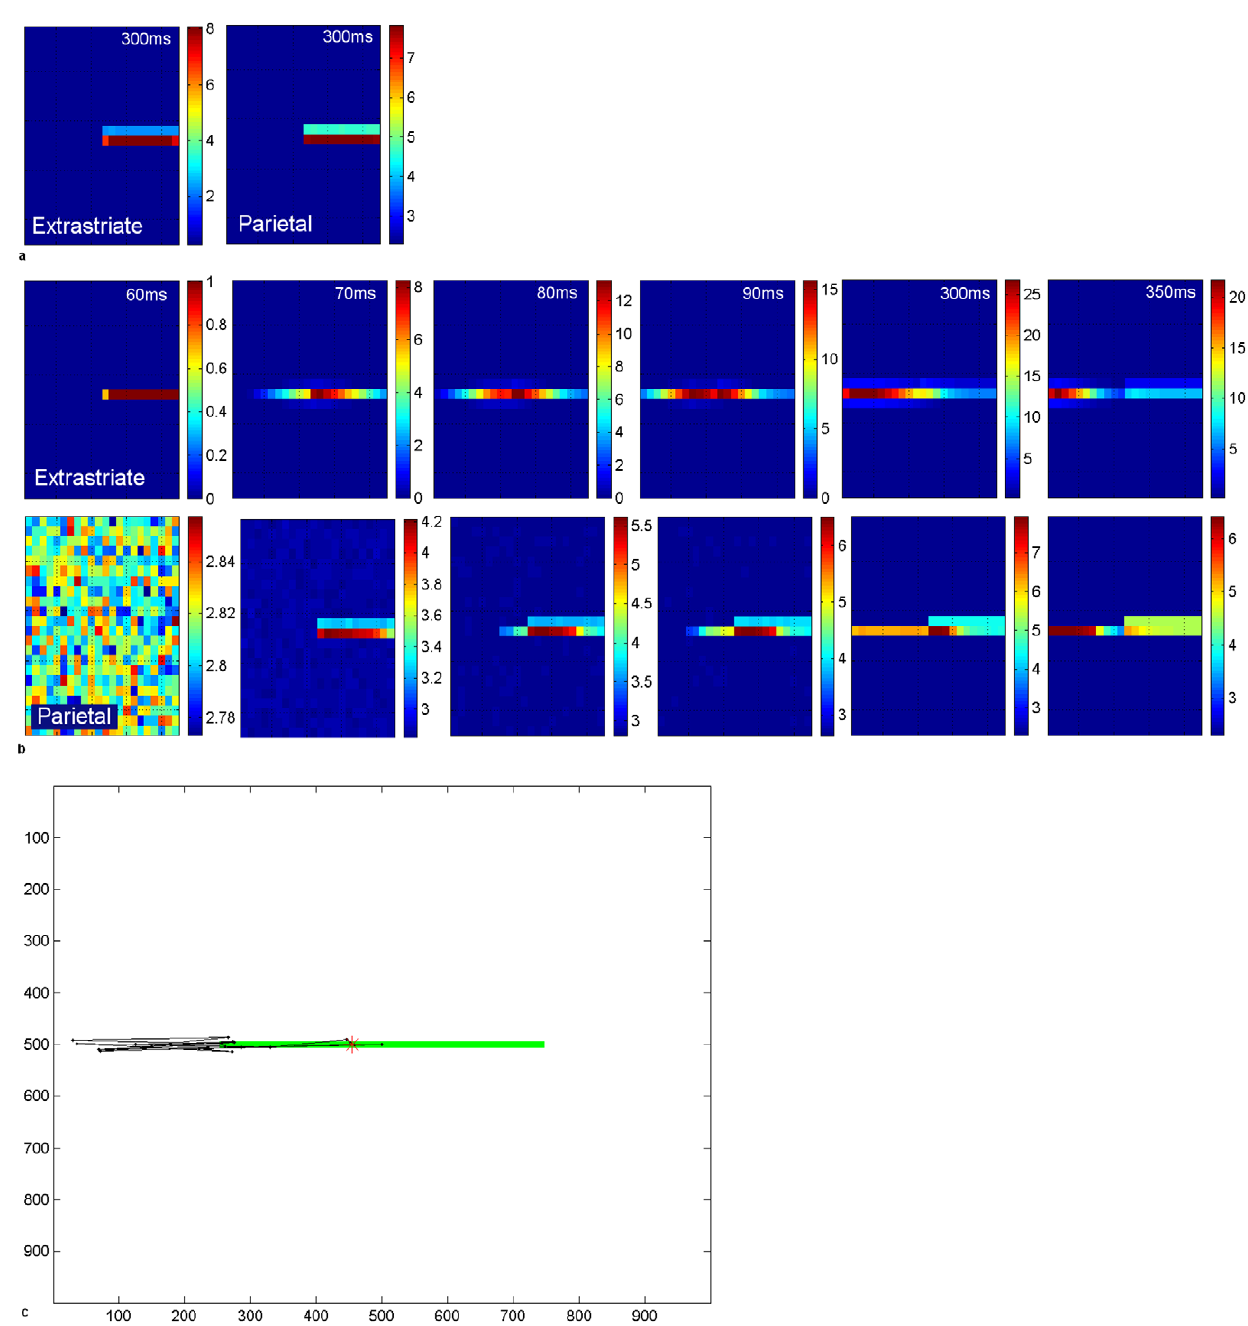
Figure 7. Cortical activity in hemianopia with and without extrastriate lateral connections. a. Acute hemianopia. Shows activity in the retinotopically-arranged horizontally selective extrastriate cells (left) and parietal (right) modules in the absence of lateral connections, at 300 ms post-fixation. Part of the line is represented in the normal hemifield but the blind hemifield is inactive due to lack of V1 inputs, despite the fact the line actually extends across the whole retina at this fixation point. Since only the intact hemifield contains stimulus-related activity in the parietal module, the next location to attract attention will be on the line in this hemifield. This reflects acute hemianopia before any rehabilitation training. Level of activity is given by the coloured bar. b. Hemianopia with perceptual completion. The top row shows activity in the extrastriate module for the cells selective for horizontal orientations, when lateral connections are enabled. Subplots show activity at 60 ms (onset of the stimulus-related response), 70 ms, 80 ms, 90 ms, 300 ms and 350 ms after fixation at the centre of the horizontal line. The bottom row shows the associated activity in the parietal module. Over time, the left of the line becomes most strongly represented and, therefore, will be chosen as the next saccade target. Note that levels of activity become high in extrastriate and parietal cortices for the blind hemifield. Level of activity is given by the coloured bar. c. Hemianopic scanpath with extrastriate lateral connections. The bisection point, which is offset contralesionally to the midpoint (position 455: 2 4.1 u offset, which is a contralesional error of 9.1% of line length), is shown as a red asterisk. In this simulation the bisection task bias weight was 3 and no spatial compensation was involved. Axes refer to pixel position in the scene.